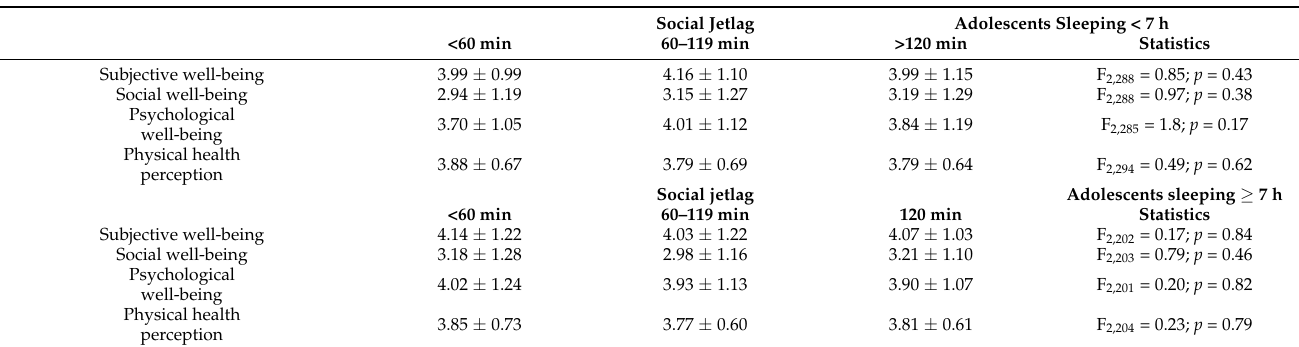
Table 5. Means and standard deviations of subjective, social, and psychological well-being as well as physical health perception according to the extent of the social jetlag, separately for sleep duration group. Statistics are also reported.